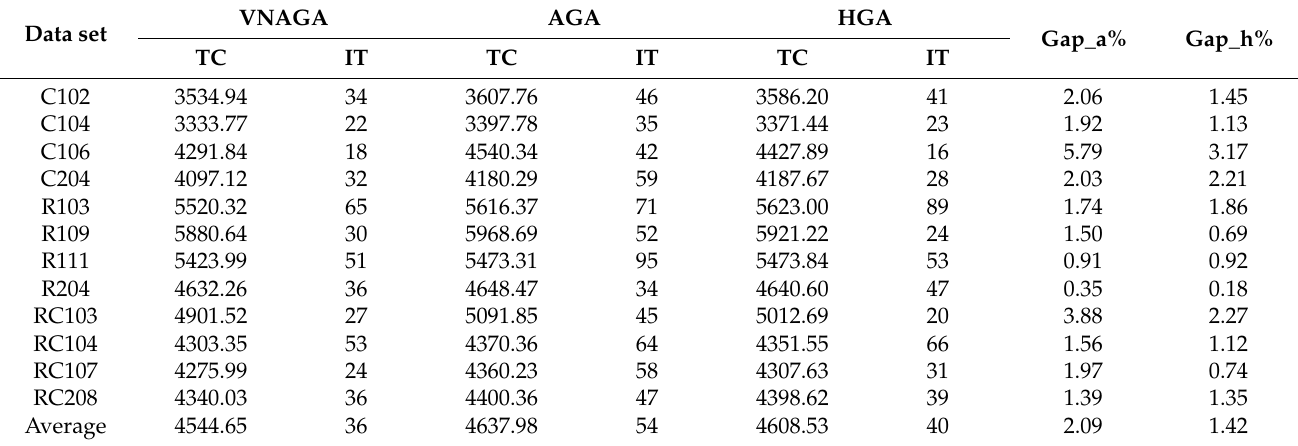
Table 2. Comparison of experimental results in TDGVRPSTW